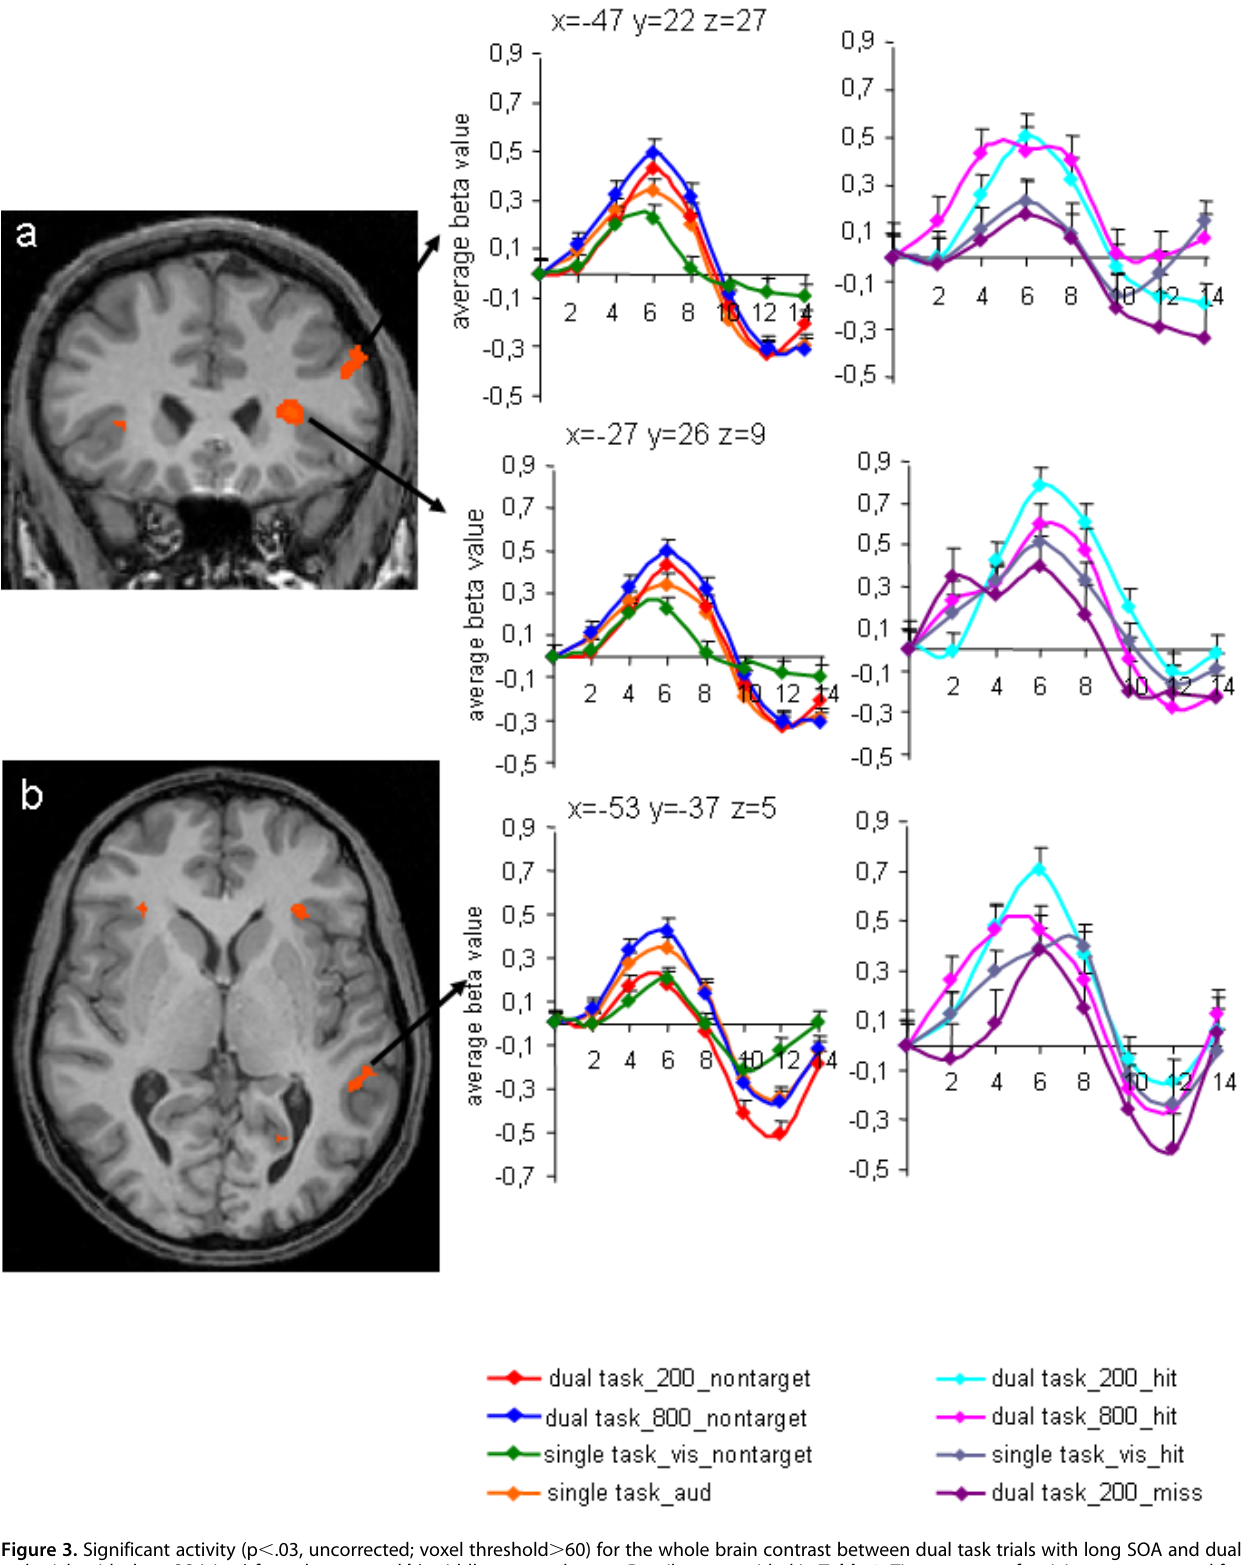
Figure 3. Significant activity (p , .03, uncorrected; voxel threshold . 60) for the whole brain contrast between dual task trials with long SOA and dual task trials with short SOA in a) frontal cortex and b) middle temporal gyrus. Details are provided in Table 2 . Time courses of activity were extracted for dual task trials with short and long SOA and nontarget letters (dual task_200_nontarget; dual task_800_nontarget), dual task trials with short and long SOA and successfully identified letter targets (dual task_200_hit; dual task_800_hit), single visual trials with nontargets and successfully identified letter targets (single task_vis_nontarget, single task_vis_hit), single auditory trials (single task_aud) and dual task trials with short SOA and letter target misses (dual task_200_miss), in contrast to the null trial activation baseline. Error bars indicate standard errors.